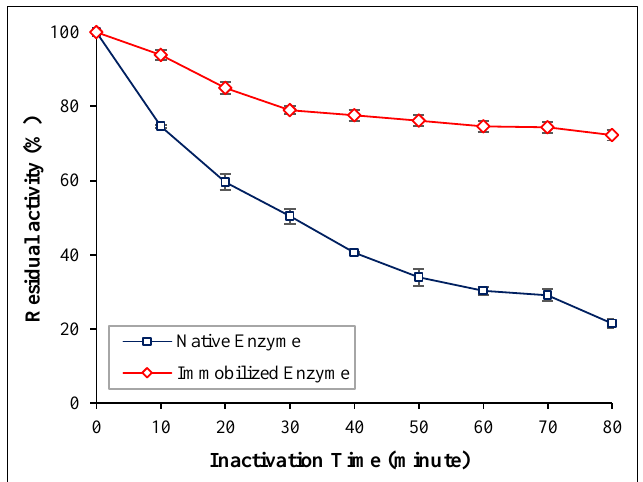
Figure 6. Thermal stability of the native and immobilized enzymes at 60°C (mean ± SD; n = 2; p <